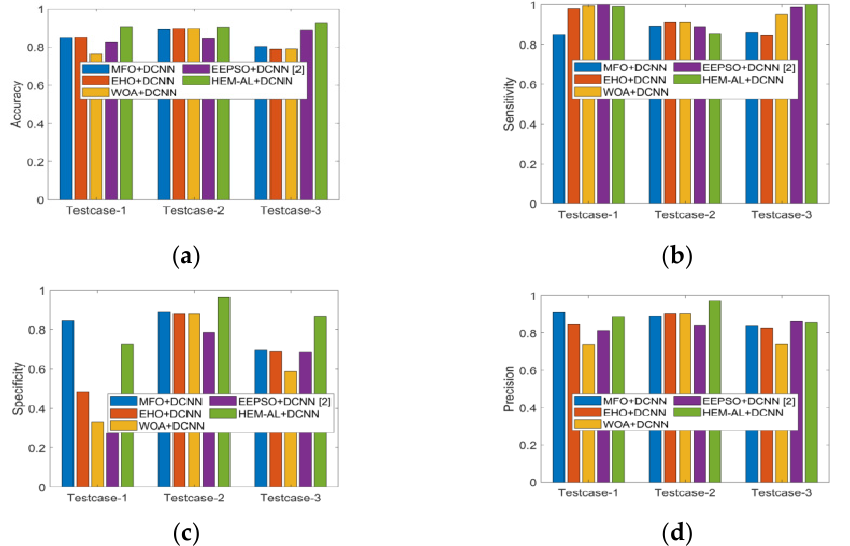
Figure 4. Performance of the developed scheme over extant schemes for “( a ) Accuracy ( b ) Sensitivity ( c ) Specificity ( d ) Precision”.